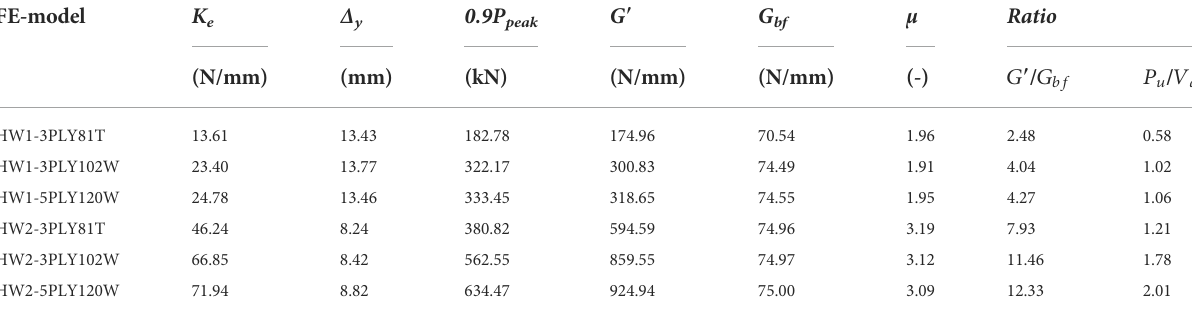
TABLE 4 Summary of numerical results.